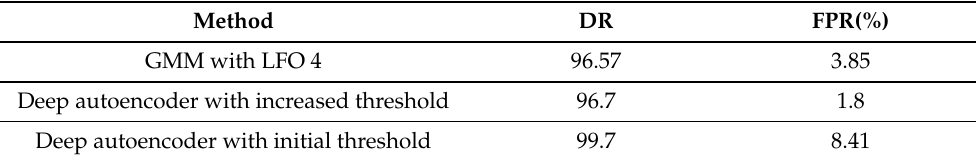
Table 2. Performance evaluation of deep autoencoder method and GMM